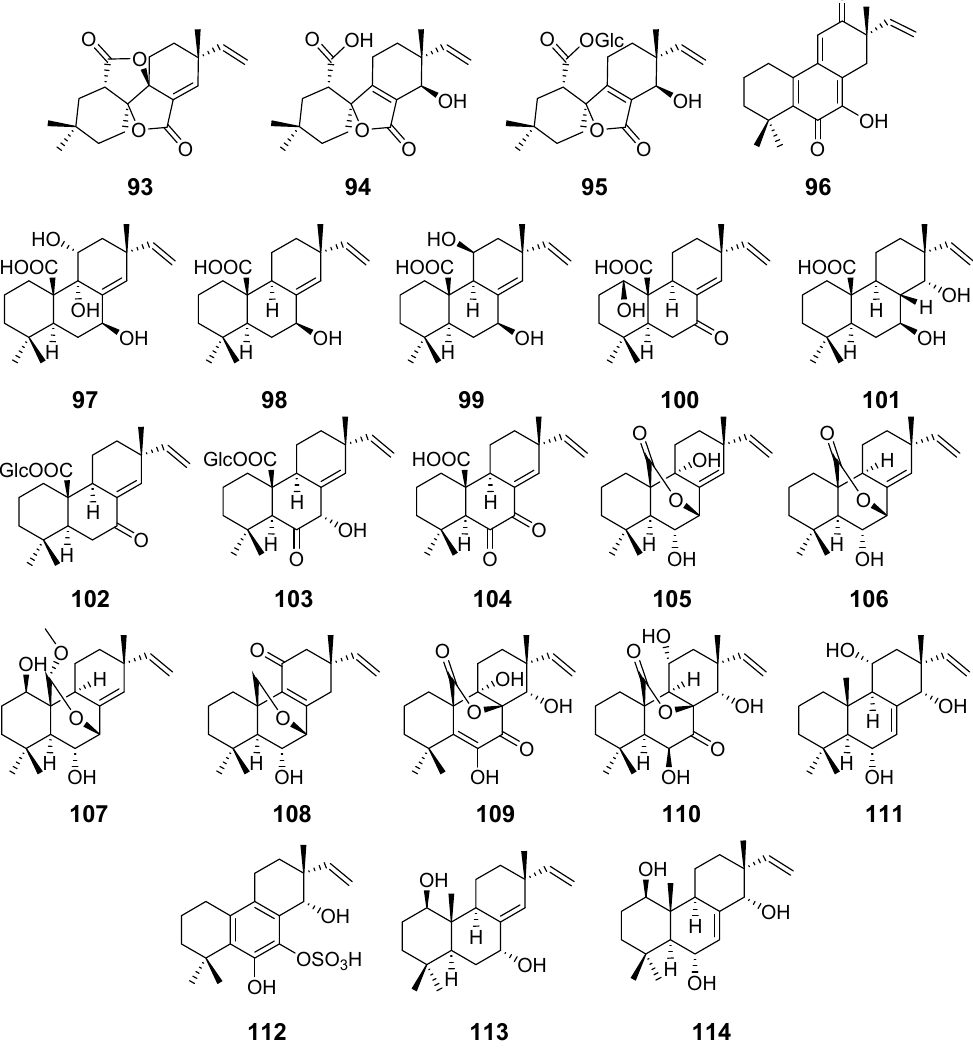
Figure 10. Structures of compounds 93 – 114 . From the fungus Xylaria sp., xylarenolide ( 115 ) (Figure 11) was obatained [46]. From the wood-decay fungus X. allantoidea. , xylallantins A–C ( 116–118 ), along with compounds 24 , 25 and 115 , were isolated [47]. From the fungicolous fungus X. longipes, Xylarilongipins A ( 119 ) and B ( 120 ) (Figure 11) both with an unusual bicyclo [2.2.2] octane structure, and compound 26 , were obtained. Compound 119 exhibited moderate concanavalin A-induced T lymphocytes and lipopolysaccharide-induced B lymphocytes with IC 50 values of 13.6 and 22.4 µ M, respectively [48]. From the same strain, xylarinorditerpene A–R ( 121 – 138 ) (Figure 12) were purified and obtained. Compound 122 – 125 , 129 , 134 , 137 and 138 were able to inhibit the proliferation of T and B lymphocytes and showed immnosuppressive activity [49]. From the solid culture of the fungus X. longipes , Xylongoic acids A–C ( 139–141 ) (Figure 12) were obtained [50]. From another fungus Xylaria sp., which was wood-decay, a hymatoxin-like isopimarane ( 142 ) (Figure 13) and compound 24 were obtained [51]. From the endophytic fungus Xylaria sp., three isopimarane diterpenes, 14 α ,16-epoxy-18-norisopimar-7-en-4 α -ol ( 143 ), 16- O -sulfo-18- norisopimar-7-en-4 α ,16-diol ( 144 ) and, 9-deoxy-hymatoxin A ( 145 ) (Figure 13), were obtained. The antifungal assays displayed their moderate antifungal activity [52].